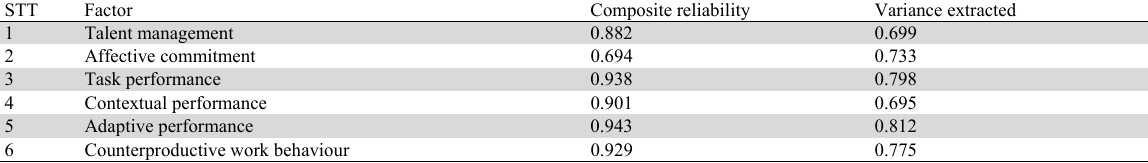
Composite reliability and total variance extracted of factors